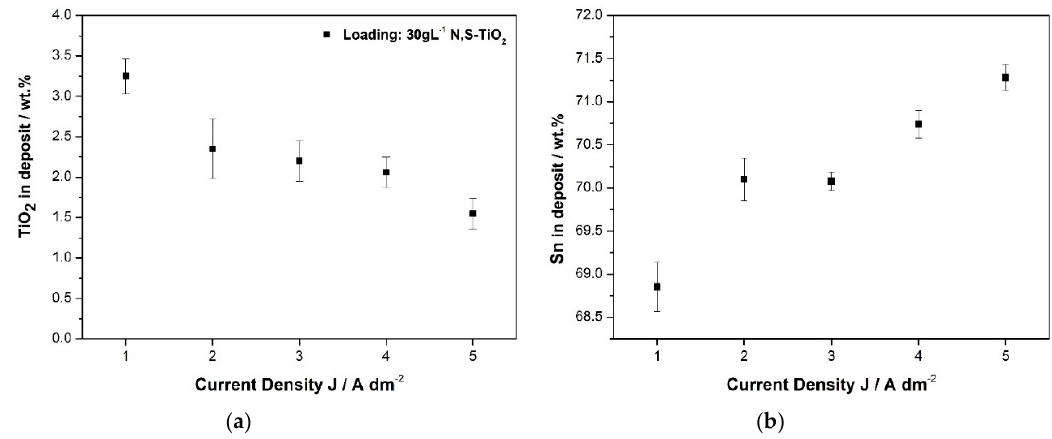
Figure 5. ( a ) Weight percentage of N,S-TiO 2 particles, immobilized within the alloy matrix at 30 g·L − 1 TiO 2 loading and ( b ) weight percentage of Sn content in the composite coating, as a function of current density values.